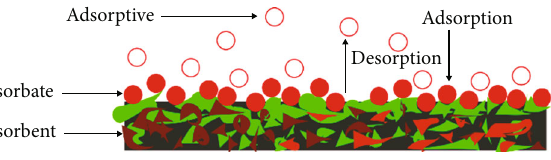
Figure 7: Adsorption mechanism.